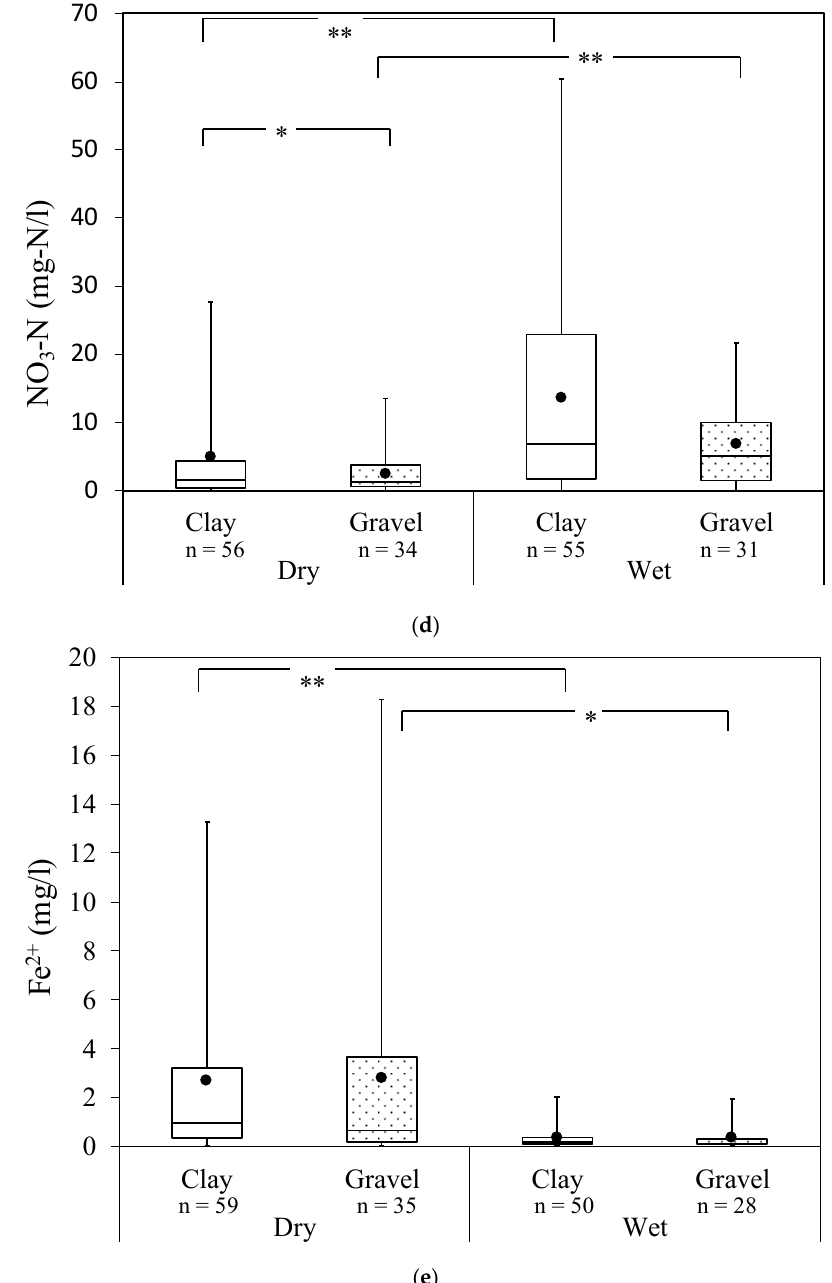
Figure 3. Graphical representation of ( a ) water table level and ( b ) Cl − (mg/L), ( c ) NH 4 -N (mg-N/L), ( d ) NO 3 -N (mg-N/L), and ( e ) Fe 2+ (mg/L) concentration. Each whisker represents inter-quartile ranges up to 1.5; the dots represent average concentrations; the lines above and below the boxes represent the 90th and 10th percentile values, respectively. (*) and (**) above boxes represent observed significance levels (p-values) less than 0.05 and 0.01, respectively.